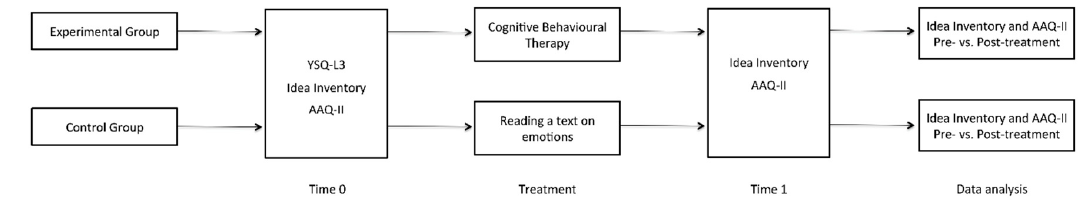
Figure 1. Schematic representation of the study procedure.